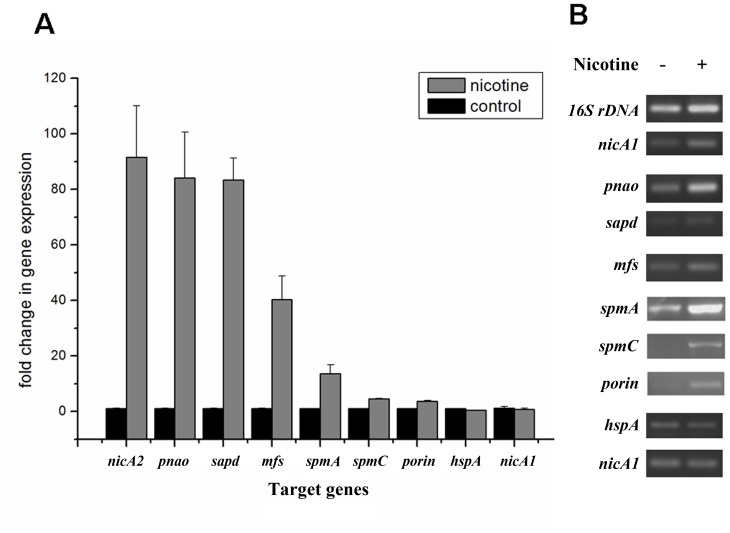
Validation of transcriptional regulation of differentially expressed proteins.RT-qPCR and semi-quantitative RT-PCR analysis of target gene transcripts produced in P. putida S16 grown with or without nicotine. A. mRNA expression levels of 9 target genes involved in nicotine degradation of P. putida S16 were estimated using RT-qPCR and the 2ΔΔCT method. The 16S rRNA gene was used as the reference gene. Results presented in these histograms are the means of three independent experiments, and error bars indicate the standard deviations. B. Semi-quantitative RT-PCR analysis of target gene transcripts produced in P. putida S16 grown with or without nicotine. The expression of 16 S rDNA was used as an internal control. Primers specific for target genes and 16 S rDNA were used to amplify fragments by RT-PCR.